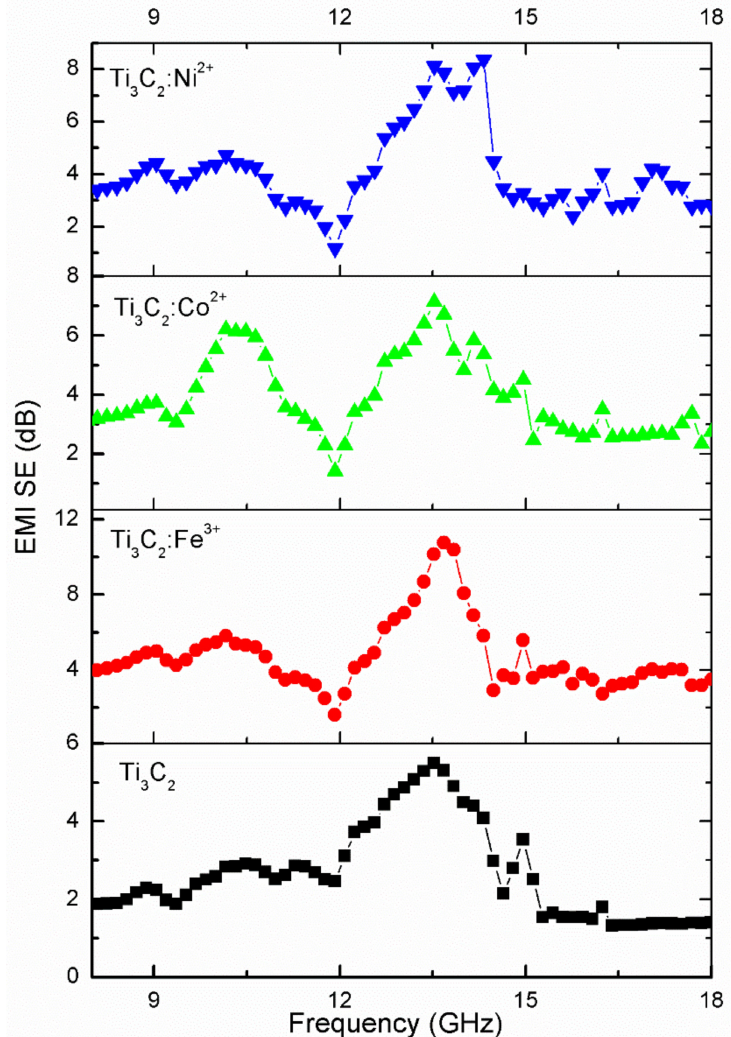
Figure 8. EMI SE-frequency curves of Ti 3 C 2 , Ti 3 C 2 /Fe 3+ /Co 2+ /Ni 2+ films from 8–18 GHz.